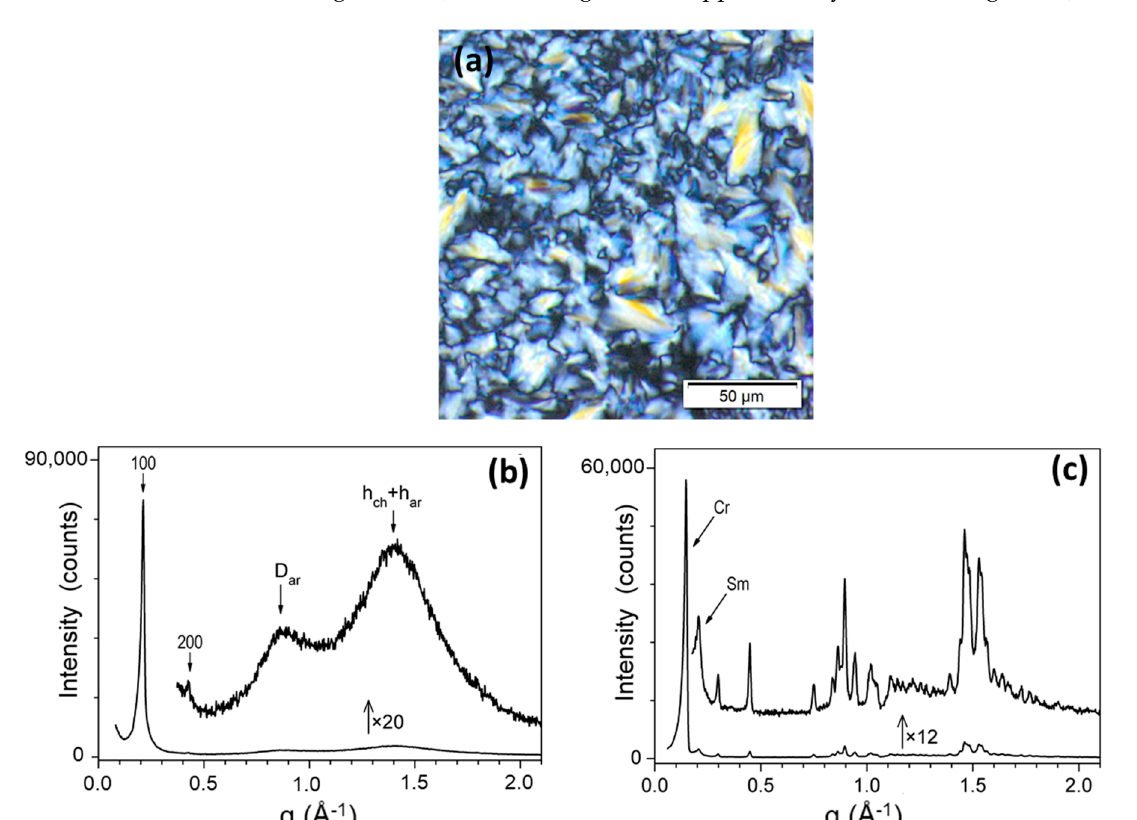
Figure 2. ( a ) POM texture of Zn_tpy on cooling at 110 °C, magnification 20×; SWAXS patterns of Zn_tpy; ( b ) at 85 °C in the mesophase and ( c ) at room temperature in the pasty pseudo-crystalline state, showing coexistence of the signals of the crystal phase and smectic A phase.